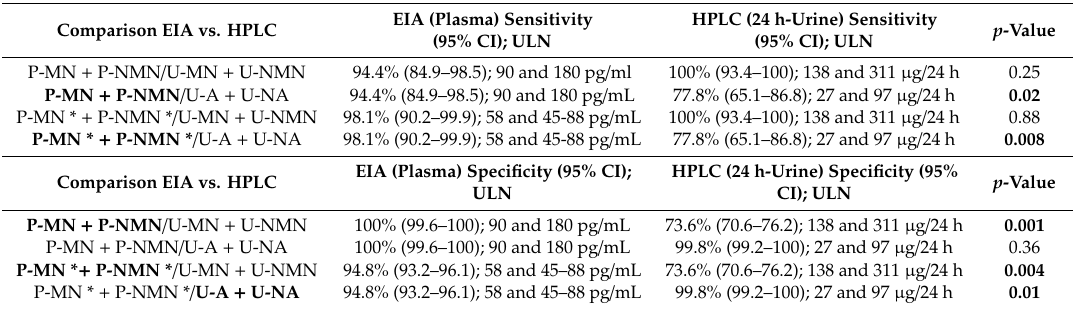
Table 4. Sensitivity (above) and specificity (below) of the pair of plasma compared to the pair of 24 h-urinary metabolites, respectively.